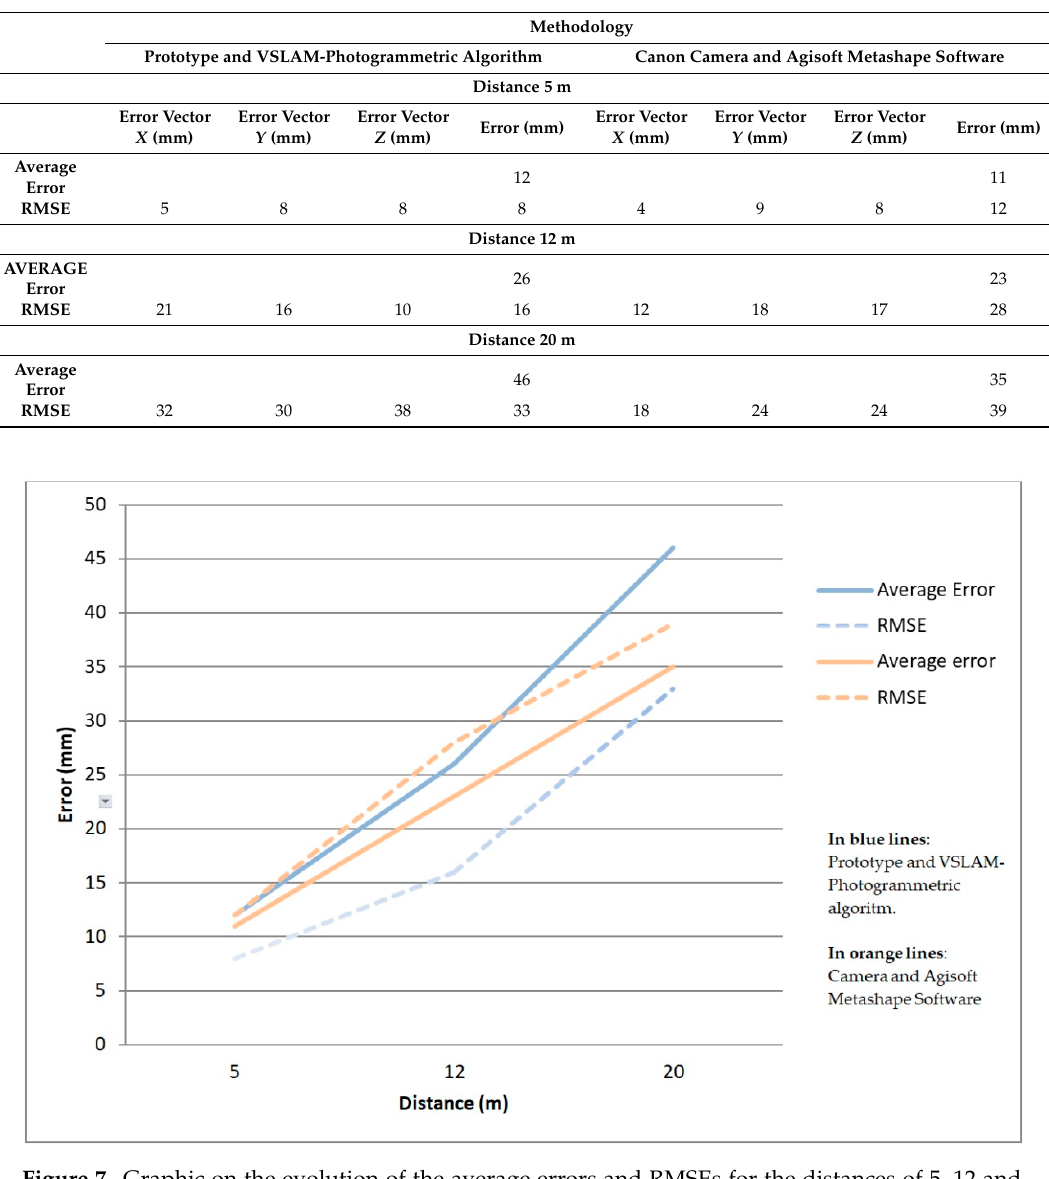
Figure 7. Graphic on the evolution of the average errors and RMSEs for the distances of 5, 12 and 20 m from the camera to the monument. The results are shown for both systems: Prototype and VSLAM-photogrammetric algorithm and Canon camera with Agisoft Metashape